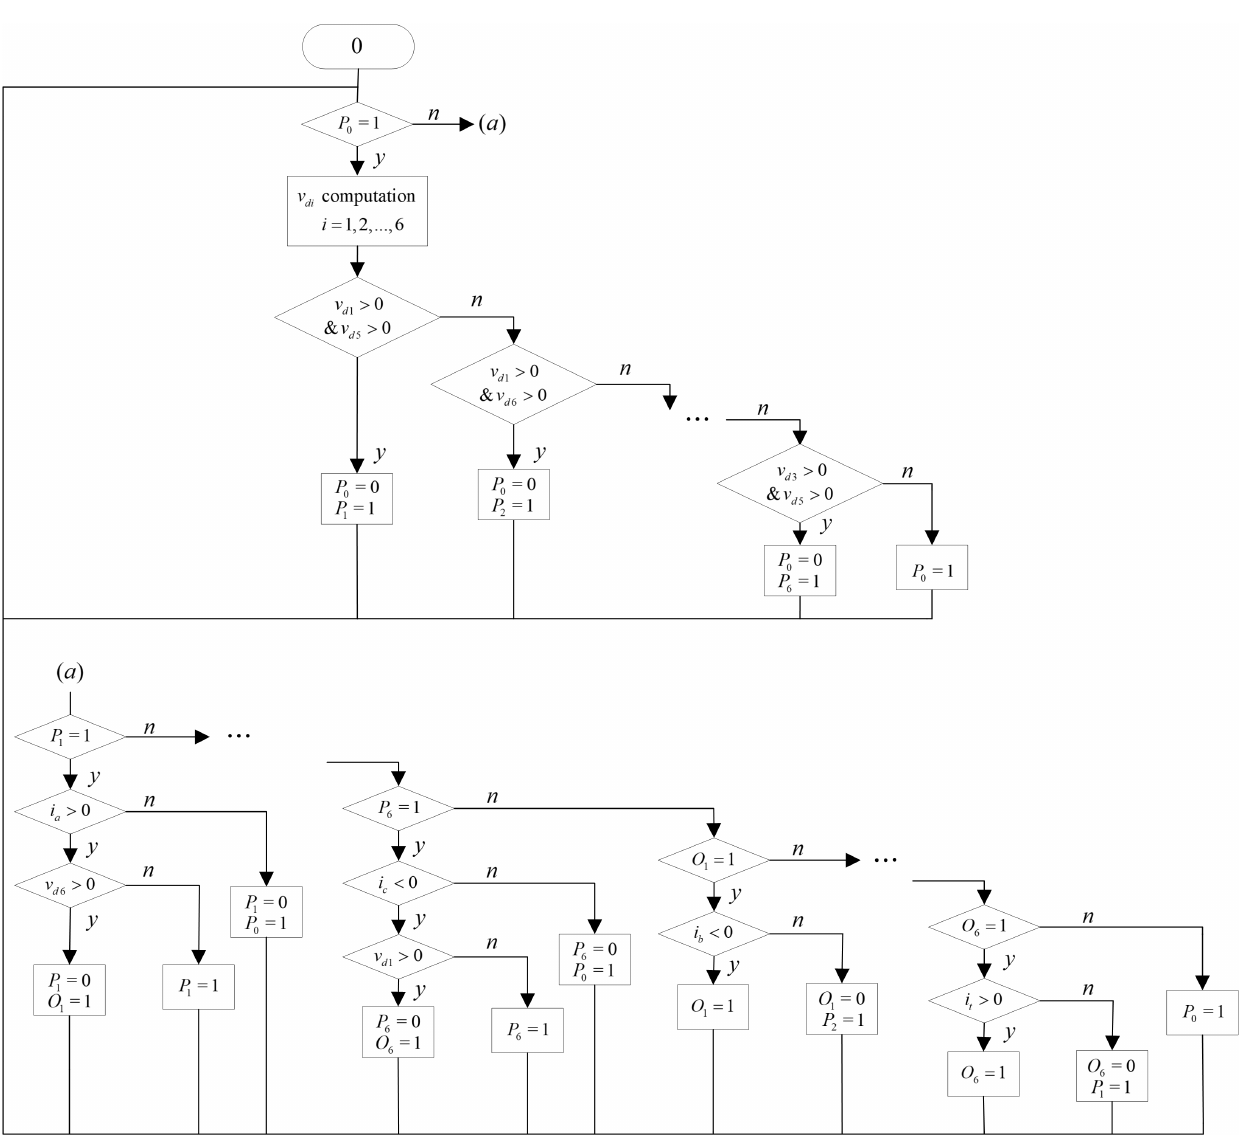
Figure 4. Flowchart of transitions between conduction and overlapping stages